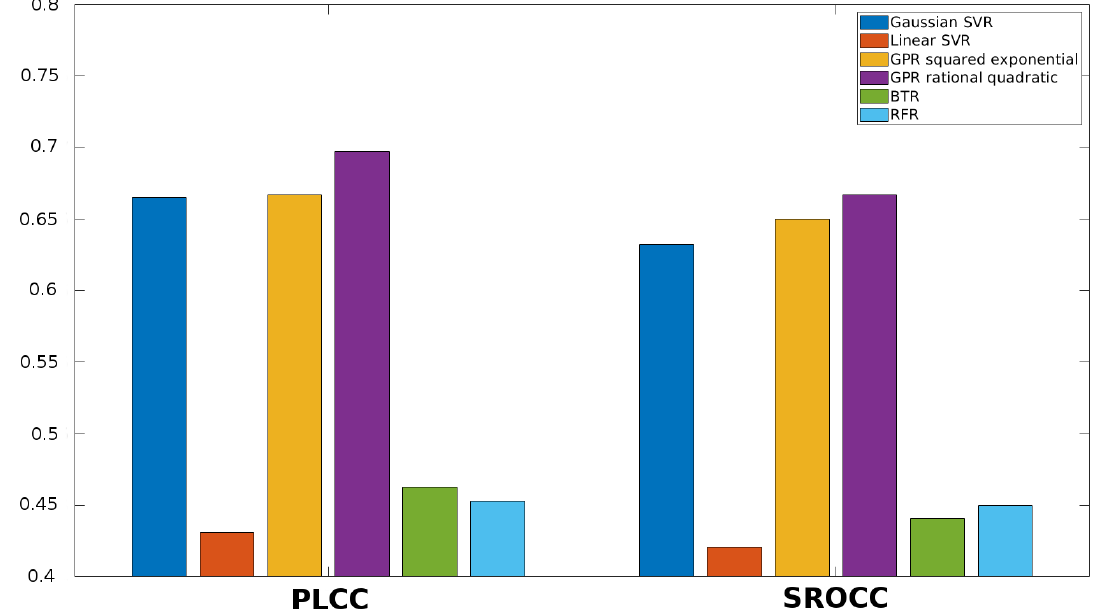
Figure 8. Comparison of different regression methods (SVR with Gaussian kernel function, SVR with linear kernel function, GPR with squared exponential kernel function, GPR with rational quadratic kernel function, BTR, and RFR). Mean PLCC and SROCC values were measured over 20 random train-test splits on TID2013